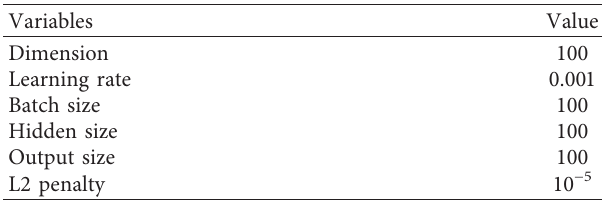
Table 2: The key variables of